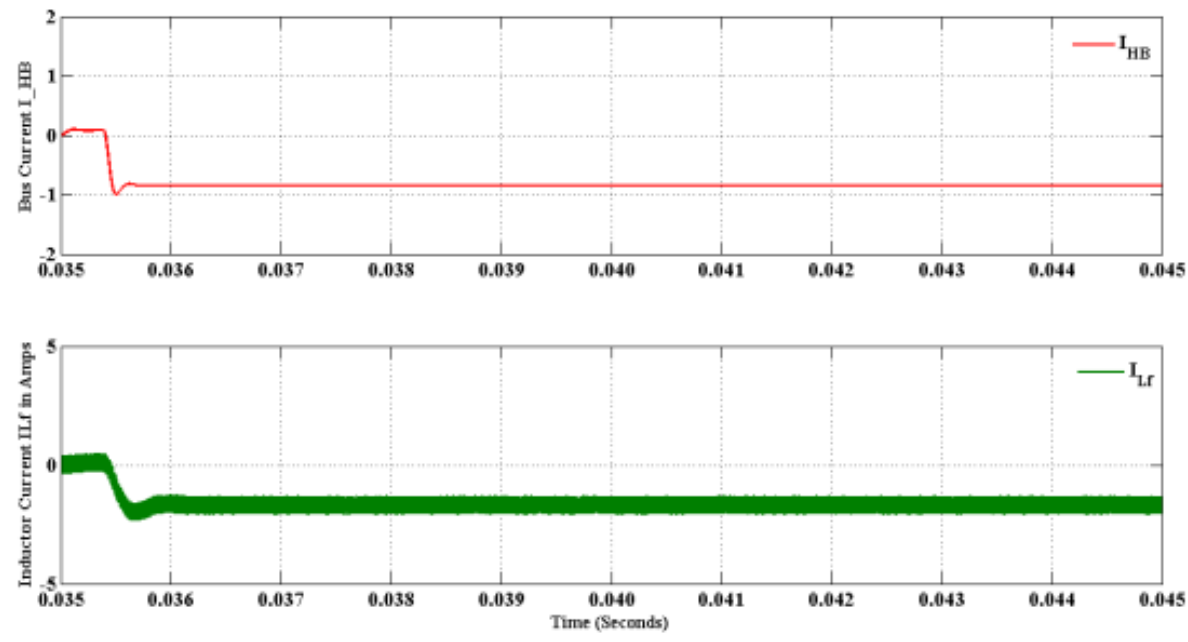
Figure 19. Regulated current step variations in inductor currents at high bus voltage.